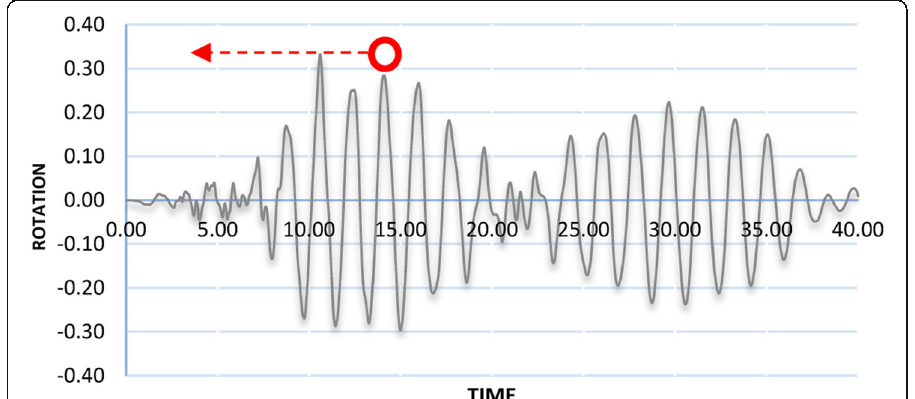
Fig. 22 Floor rotation time history (time −